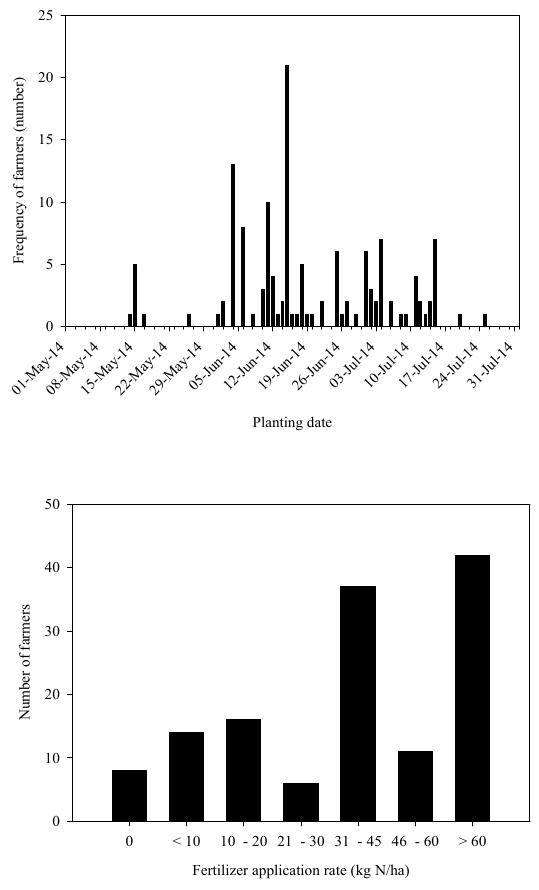
Figure 1. Distribution of planting dates and fertilizer application rates in a community at Tamale (Ghana) in a 2014 agronomy survey